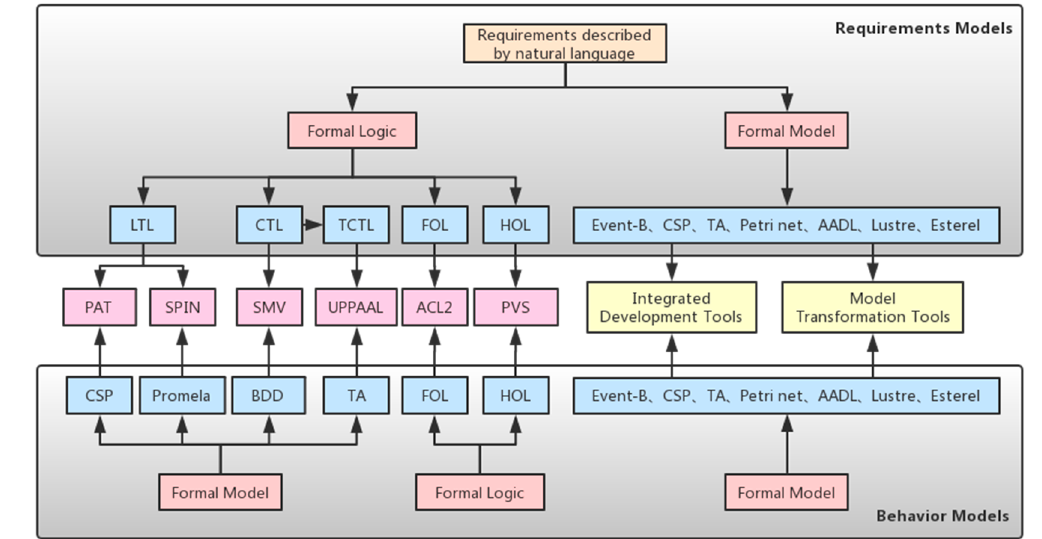
Figure 2. Formal methods of requirement and behavior models.